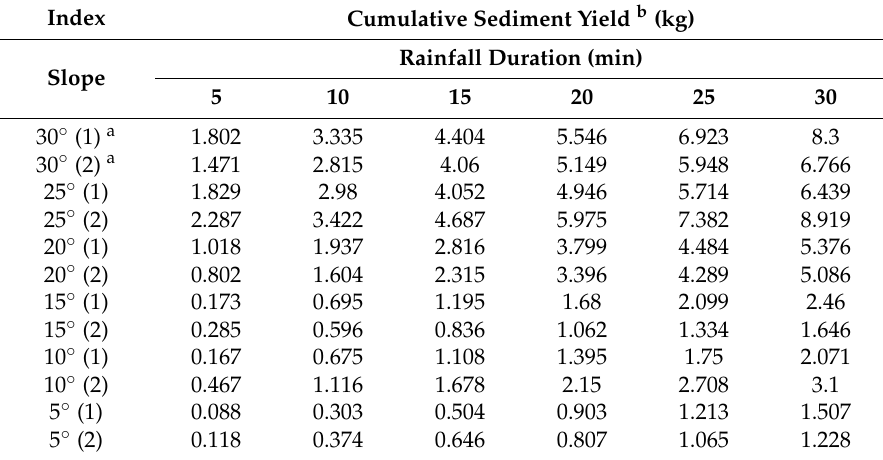
Table 1. Sediment yield measurements collected at the outlet of the